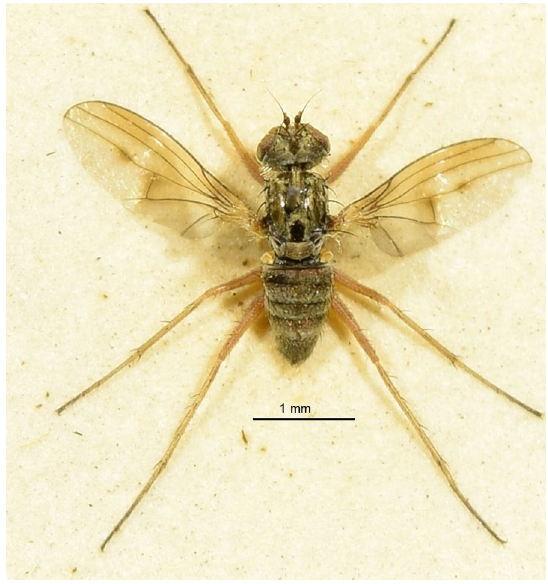
Fig. 6 Thinophilus maculatus Parent female habitus, dorsal